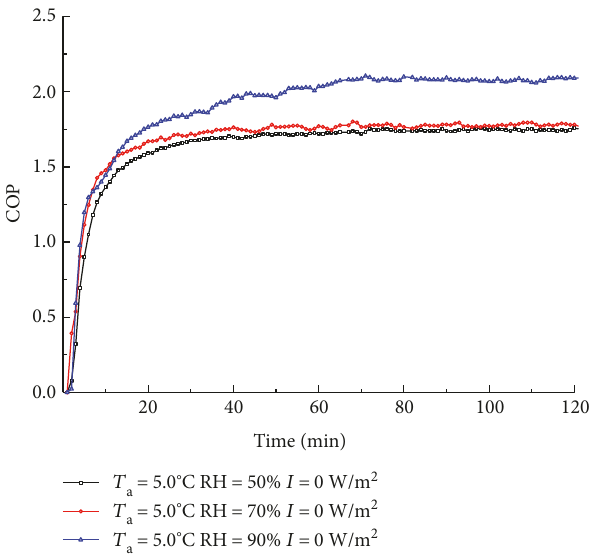
Figure 11: Variation of the energy consumption with the relative humidity of 50%, 70%, and 90%.